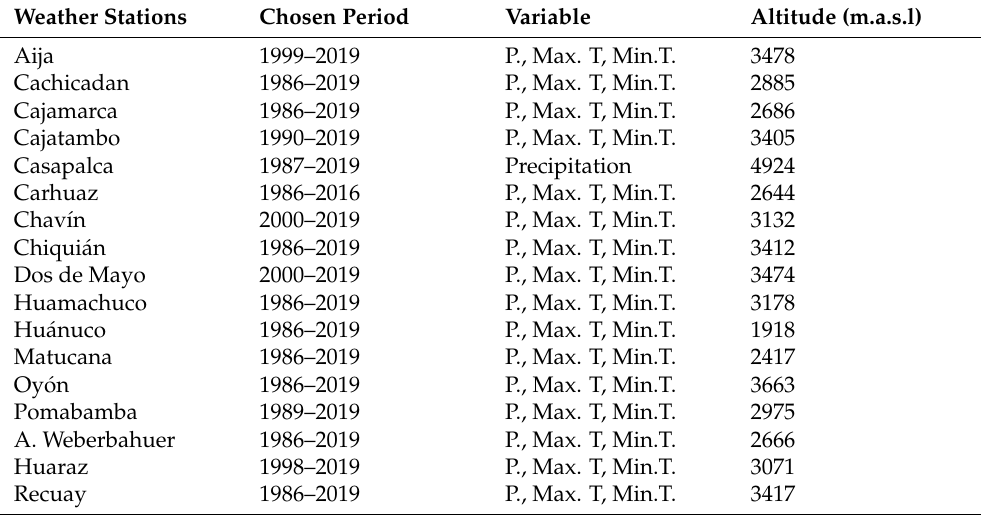
Table 1. Weather stations used in the present study. Weather